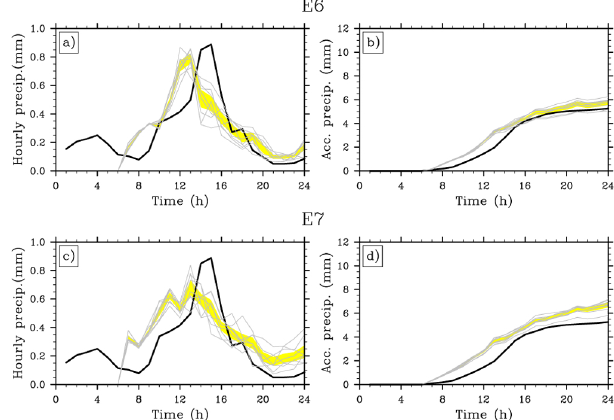
Fig. 15. As in Fig.8 but for the ensembles E6 and